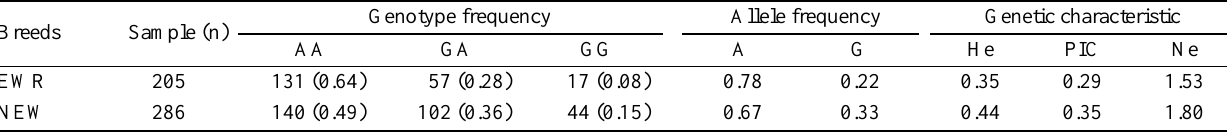
The numbers in the brackets are the genotype frequency for the respective